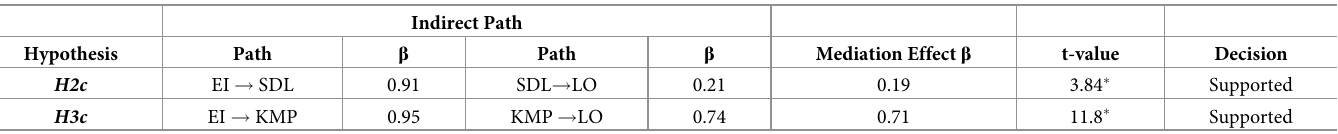
Table 5. Summary of mediation